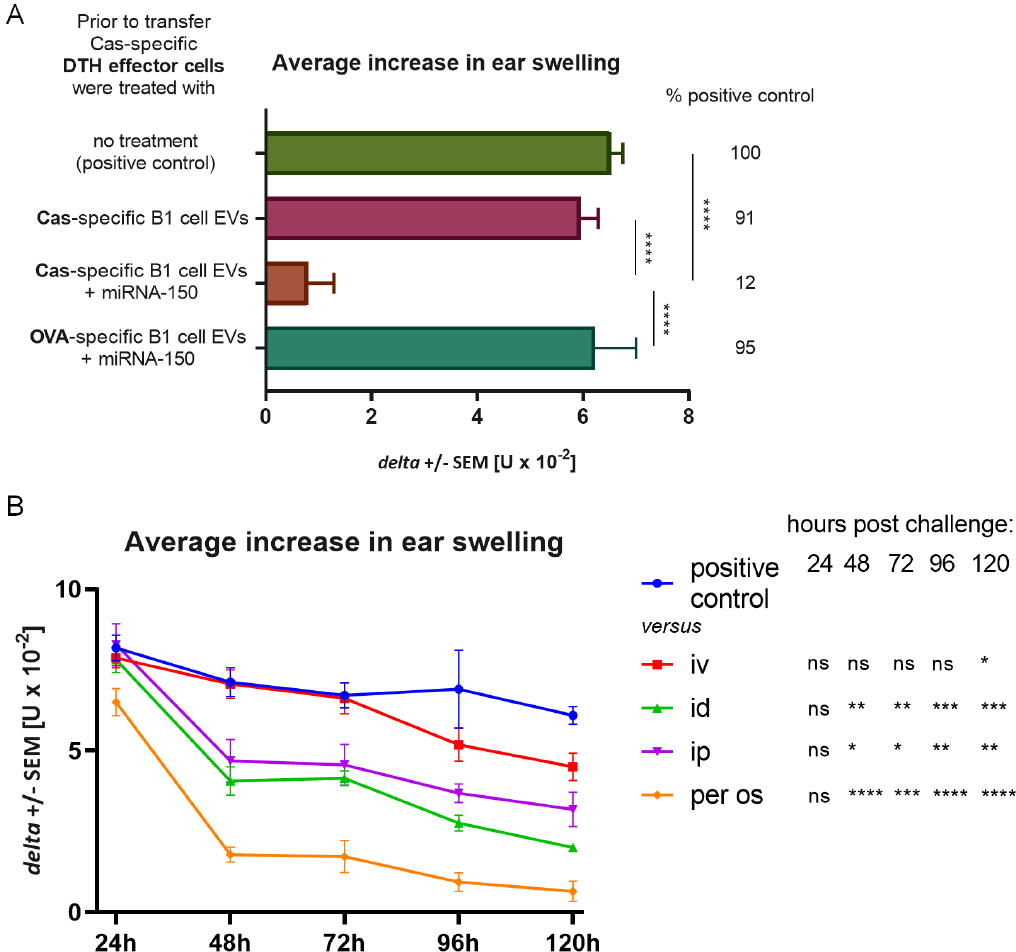
Figure 6. Suppression of delayed-type hypersensitivity (DTH) to soluble casein (Cas) antigen by miRNA-150-supplemented B1cell-derived extracellularvesicles (EVs) of Cas-immunized mice. ( A ) Mice had been intradermally (id) immunized with a saline solution of soluble Cas antigen or ovalbumin (OVA, both 100 µ g per mouse) 3 days before harvest of lymph nodes and spleens containing B1 cells, which were cultured for a subsequent 48 h. The resulting supernatant was filtered and ultracentrifuged to concentrate Cas-specific or OVA-specific B1 cell EVs, then supplemented with miRNA-150 prior to treatment of Cas-specific DTH e ff ector cells, which were adoptively transferred to recipients, challenged 24 h later by id administration of the same Cas solution (5 µ g per earlobe). After 24 h, ear swelling response was measured and expressed as delta ± SEM [units (U) × 10 − 2 mm] (n = 5, N = 2). ( B ) Mice had been id immunized with a saline solution of soluble Cas antigen (100 µ g per mouse) 5 days before challenging by id administration of the same Cas solution (5 µ g per earlobe). After measurement of 24